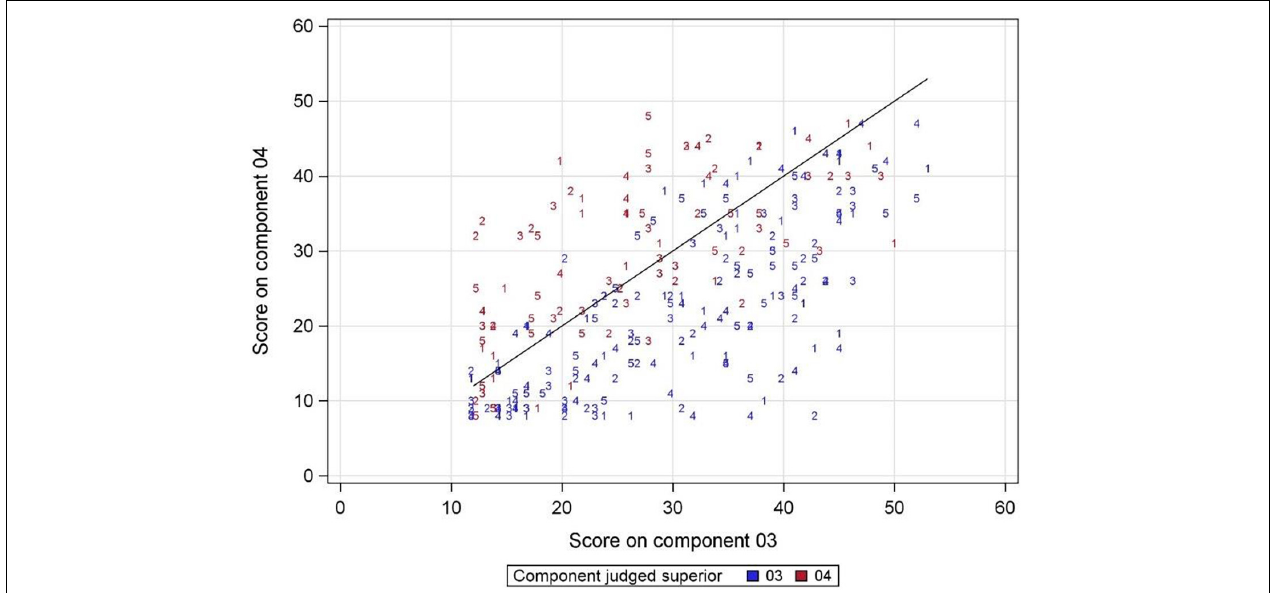
FIGURE 1 | The design of the simplified pairs study. The locations of the points show which scores on science component 03 were paired with which scores on component 04 and the numbers indicate which examiner made the judgement. The black line is a line of equality, rather than a regression line.